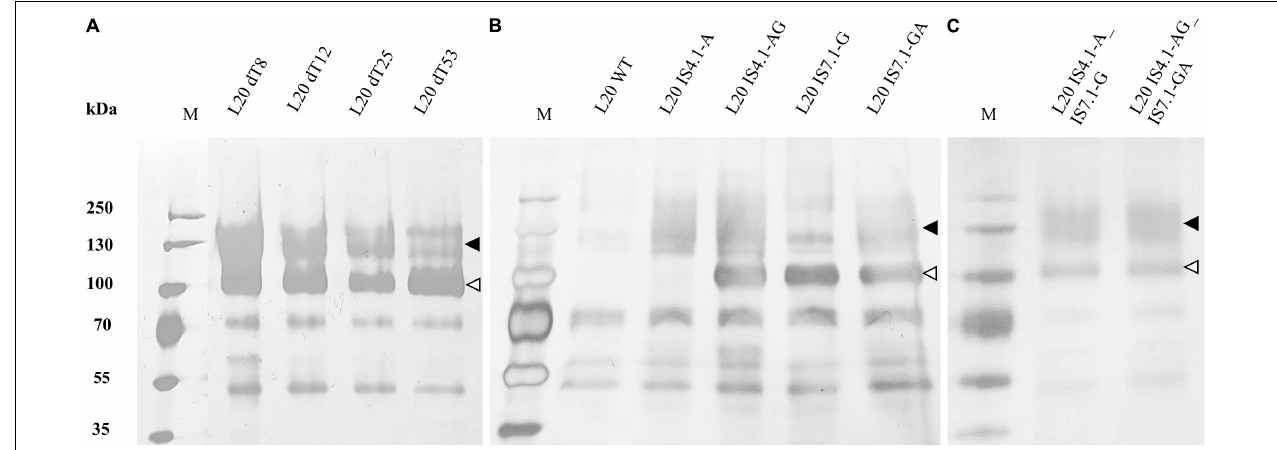
FIGURE 4 | Supernatant from 72-h cultures of S. cerevisiae L20 strains was subjected to SDS-PAGE followed by silver staining. Arrows indicate the presence of recombinant protein species ( (cid:115) ) AmyA and ( (cid:52) ) GlaA in the supernatant: (A) delta integrated, (B,C) CRISPR/Cas9 recombinants. WT indicates the parental strain. The PageRuler Prestained Protein Ladder (Fermentas) was used as protein size marker